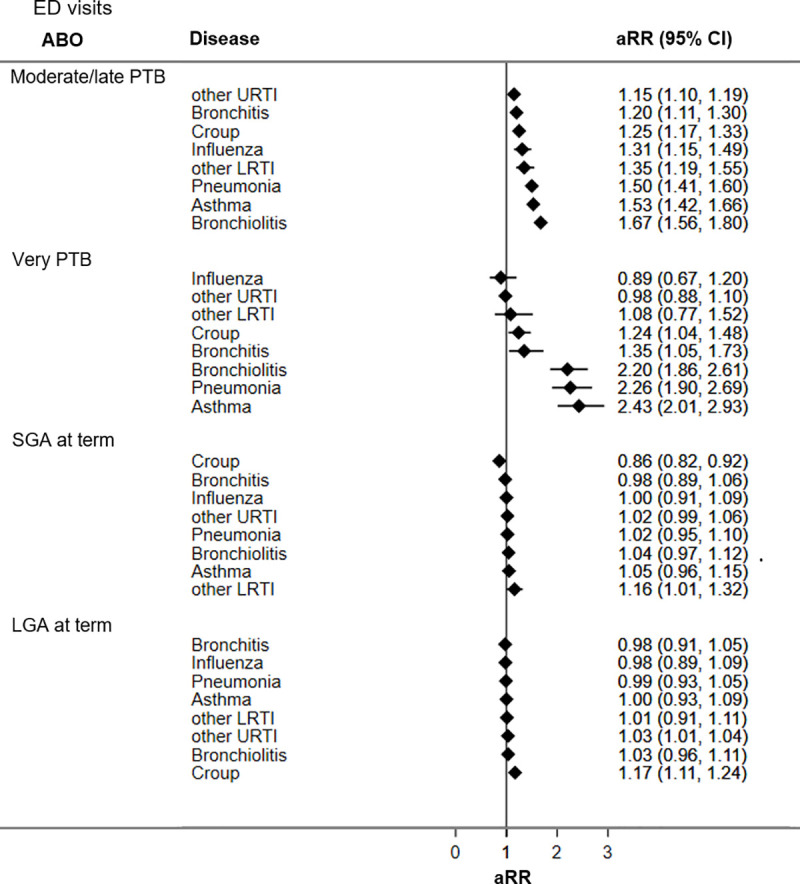
Adjusted rate ratios of respiratory hospitalizations for adverse birth groups.CI = confidence interval; LGA = large for gestational age; LRTI = lower respiratory tract infections; URTI = upper respiratory tract infections; PTB = preterm birth; SGA = small for gestational age. Reference group = appropriate-for-gestational age infants born at term; aRR = rate ratio adjusted for sex, bronchopulmonary dysplasia, Apgar 5, score, use of significant resuscitative measures, and material and social deprivation.